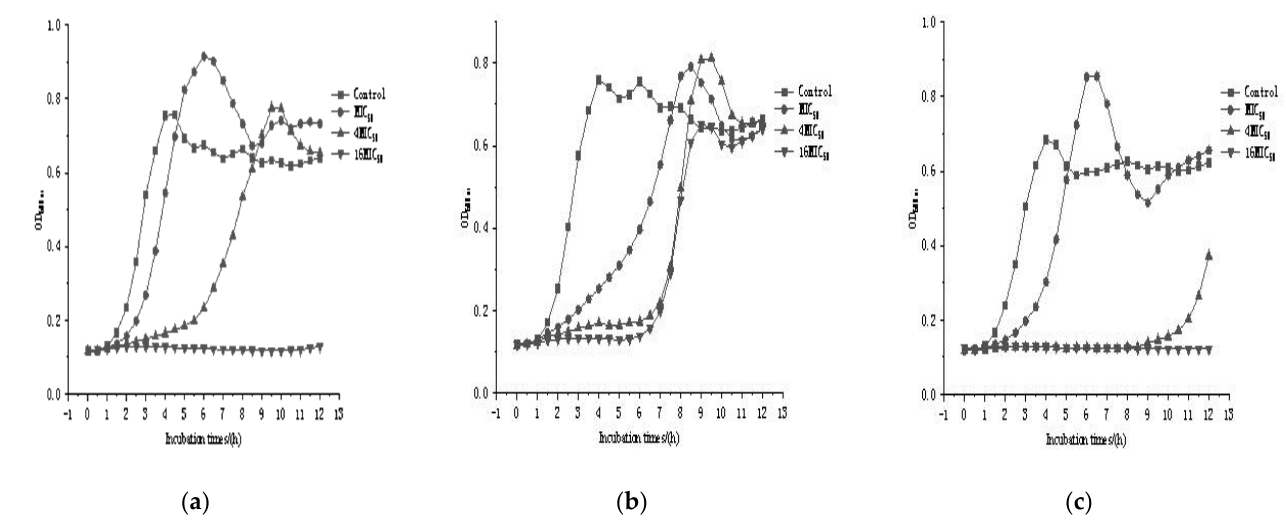
Figure 1. Growth curve of three bacteriocin producers from lactic acid bacteria against Listeria monocytogens at di ff erent half-minimum inhibitory concentrations. ( a ) DH9003; ( b ) DH9011; ( c ) DH9012.